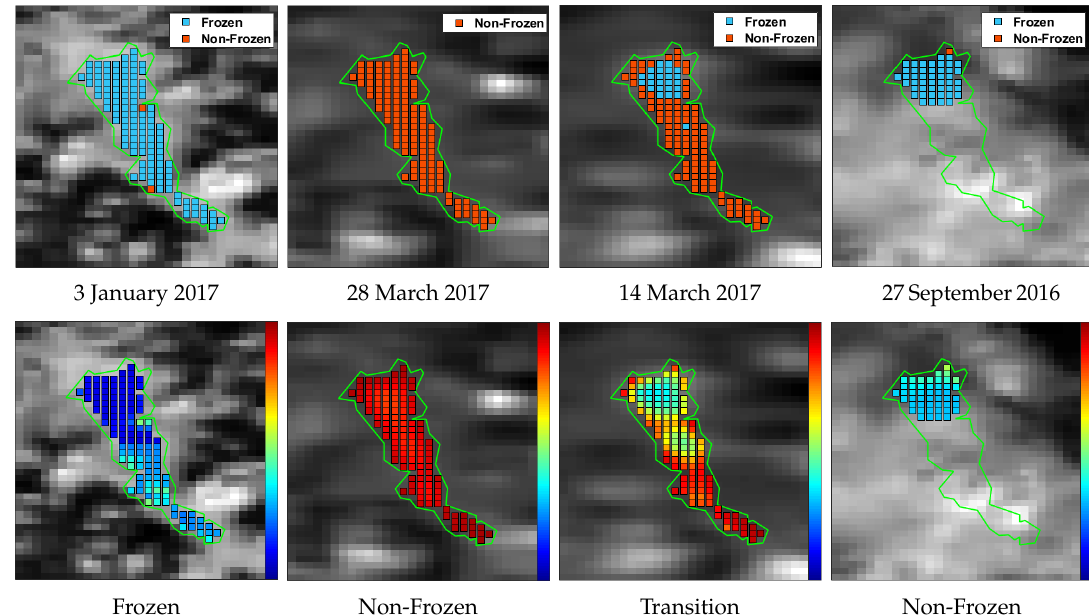
Figure 14. MODIS qualitative results using the linear kernel. Top and bottom rows show classification results and corresponding confidence respectively. Results of cloudy pixels are not displayed. First, second, and third columns show success cases while the fourth column displays a failure case. In the second row, more red means more non-frozen and more blue means more frozen. The dates and ground truth labels are shown below each sub-figure in the first and second rows